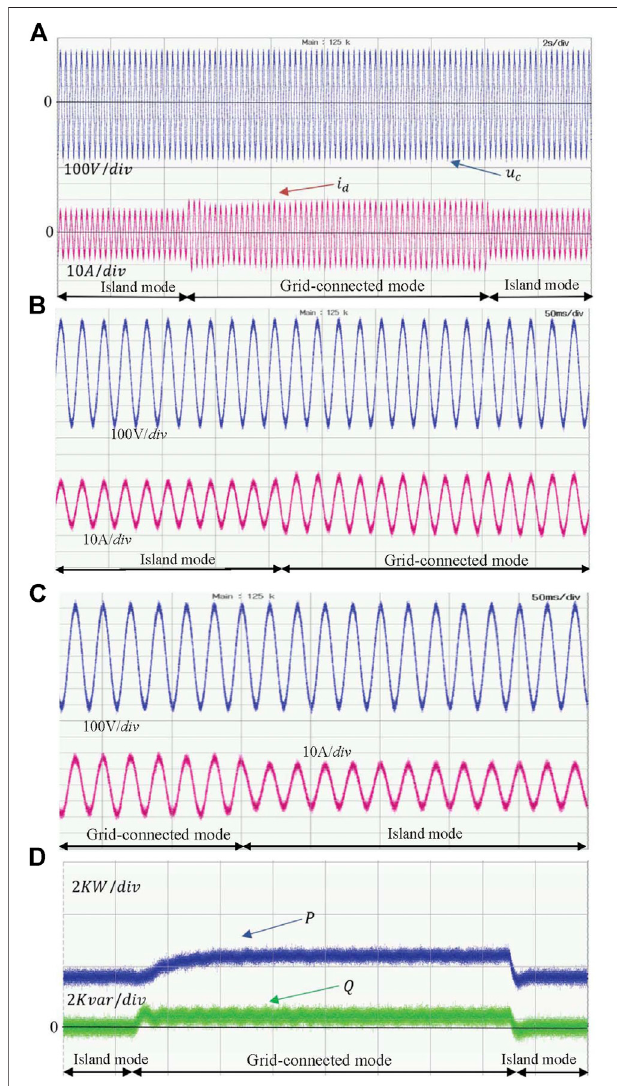
FIGURE 13 | Experimental waveform of seamless transfer. (A) Experimental waveforms of single-phase VSG capacitor voltage and load current based on seamless transfer. (B) Partial enlarged experimental waveform of the dynamic process from island mode to grid-connected mode. (C) Partial enlarged experimental waveform of the dynamic process from grid-connected mode to island mode. (D) Experimental waveform of single-phase VSG output